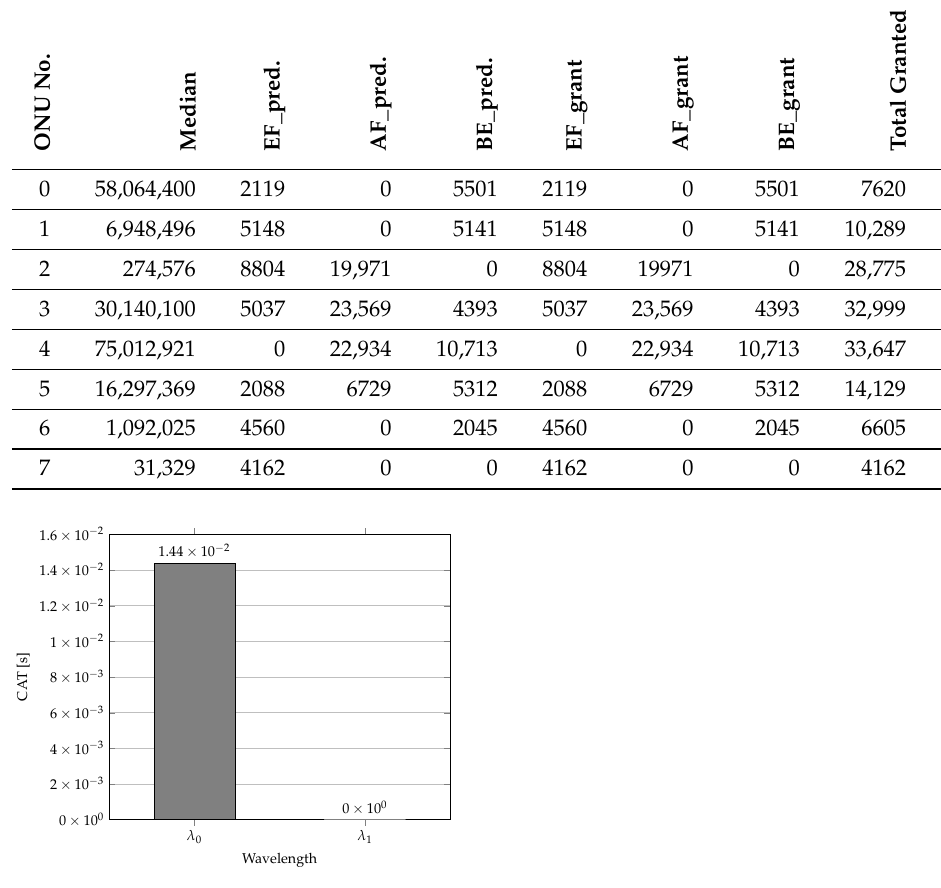
Figure 2. CAT parameter values in s for wavelengths in cycle No. 27 using Method